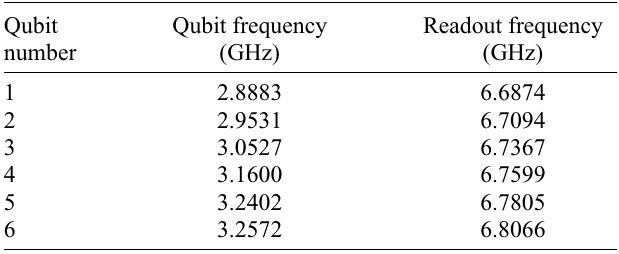
TABLE IV. Qubit chip comprising six fixed-frequency trans- mon superconducting qubits between 2.88 to 3.26 GHz and individual readout resonators between 6.69 and 6.81 GHz. The individual readout resonators couple to the common transmis- sion line. On one side of the transmission line are qubits 1, 3, and 5 and on the other side qubits 2, 4, and 6.